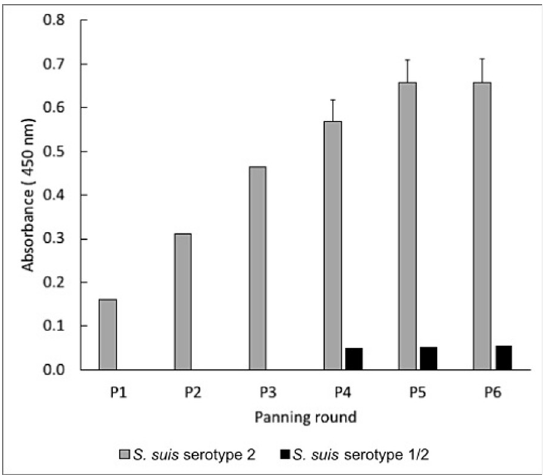
Fig 1. Enrichment of phages specific to S . suis serotype 2, as determined by polyclonal phage ELISA. Data are shown as the mean ± SD (n = 3).